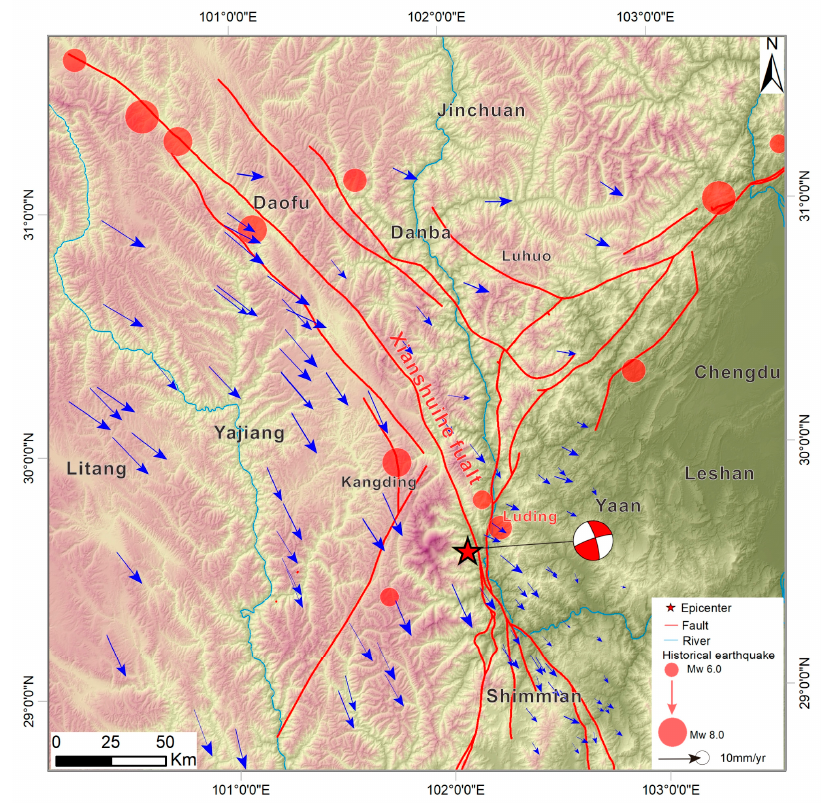
Figure 16. Regional map showing the velocity field of GNSS horizontal motion before the 2022 Luding M6.8 earthquake (from http://data.earthquake.cn; accessed on 20 October 2022) and the historical earthquakes (>Mw6) since 1900 (from USGS.gov|Science for a changing world; accessed on 20 October 2022).